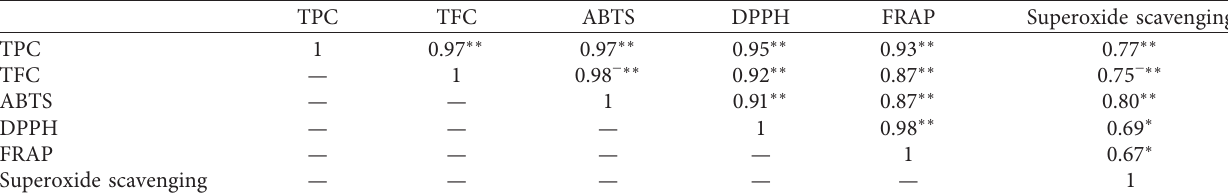
Table 4: Correlation between TPC, TFC, and four TAC values.